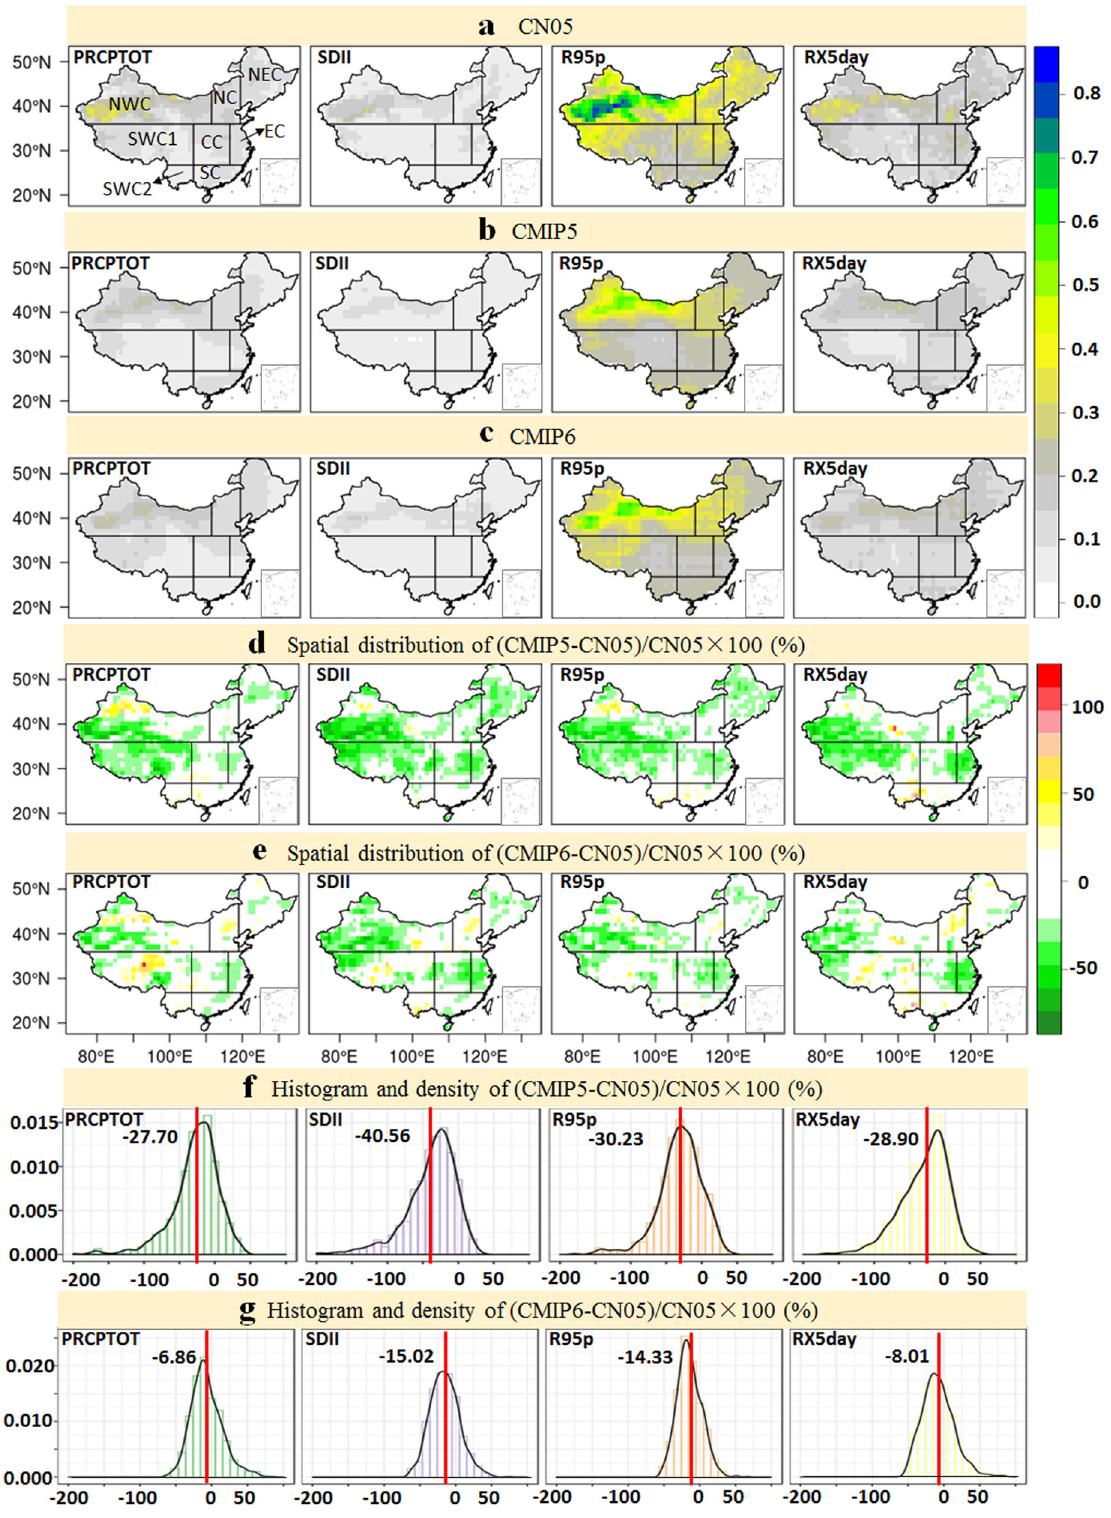
Fig. 1 Comparison of Gini-coef fi cients between observed and simulated values. Gini-coef fi cients at spatial distributions of a CN05 dataset, b CMIP5 historical simulations, c CMIP6 historical simulations, d the bias [(CMIP5-CN05)/CN05] (%), e the bias [(CMIP6-CN05)/CN05] (%), f histogram and density plots of the bias [(CMIP5-CN05)/CN05] (%), and g histogram and density plots of the bias [(CMIP6-CN05)/CN05] (%)for four indices from 1961 to 2005. Red lines are the average value for all grids. The sub fi gures were done in the software R 4.0.2 (https://cran.r- project.org/bin/windows/), and then the sub fi gures were merged by using the Microsoft PowerPoint 2013 software (https://www.microsoft.